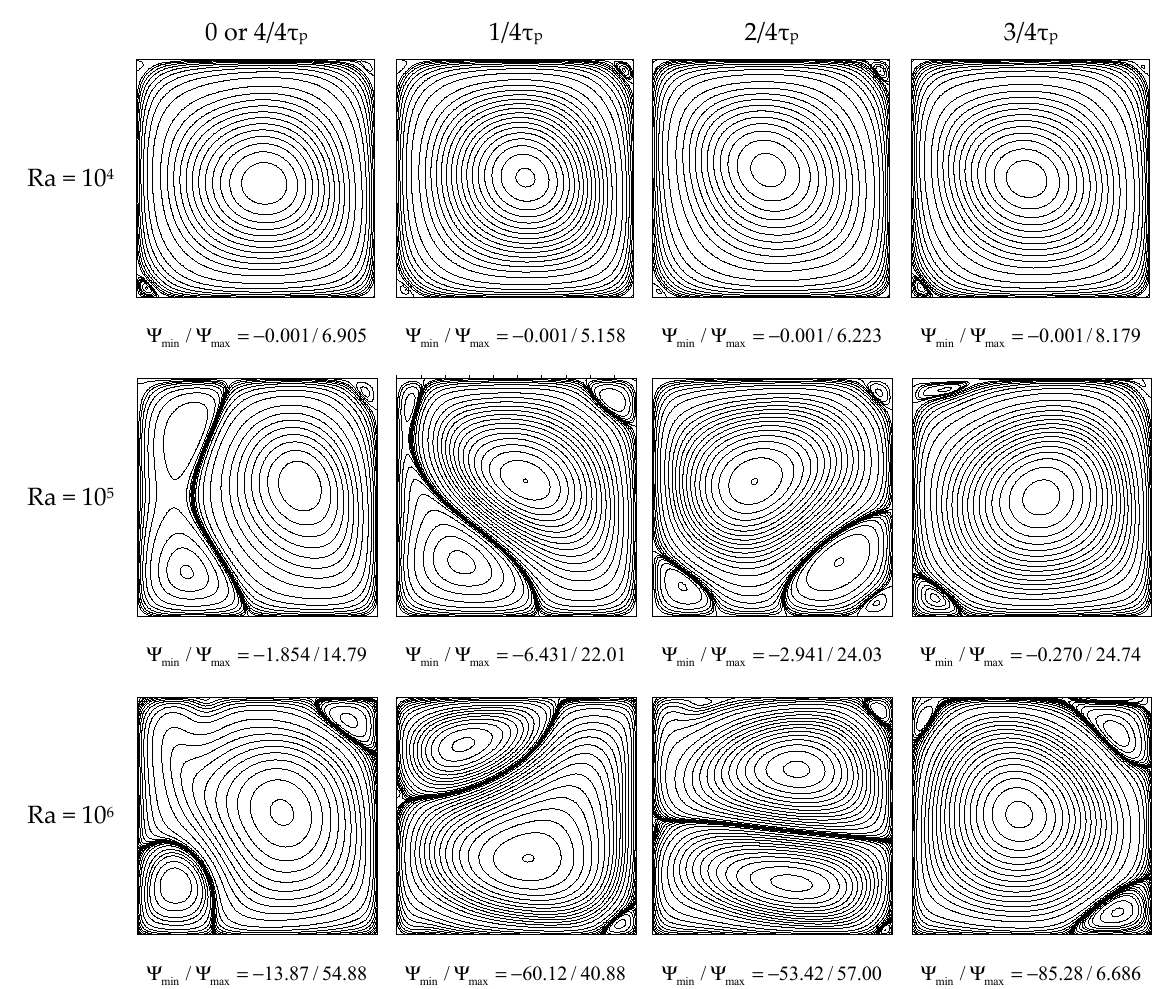
Figure 5. Evolution of streamlines “ Ψ ” over a period as a function of the Rayleigh number (Amp = 0.8 and |f| = 0 × 33 10 − 4 ).